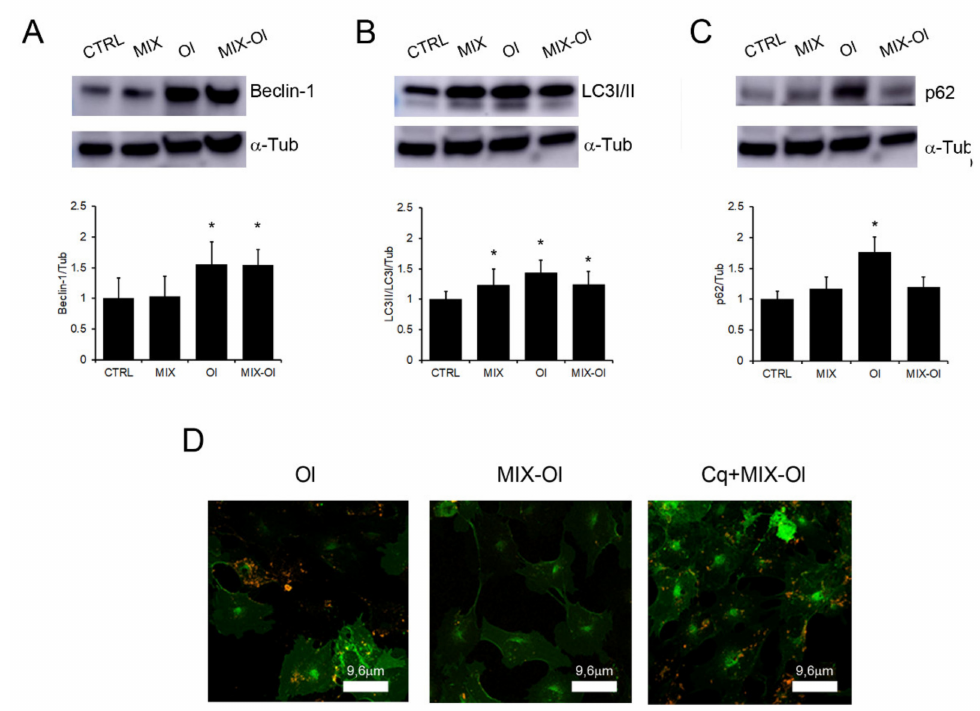
Figure 3. MIX-mediated recovery of redox homeostasis in human neuroblastoma cells depends on autophagosome– lysosome fusion. ( A – C ) The SH-SY5Y cells were treated with (i.) 75 µ M OleA/HT (MIX) for 4 h; (ii.) A β 1–42 oligomers (Ol); (iii.) MIX for 24 h followed by exposure to oligomers for further 24 h (MIX-Ol). Western blots of all the assayed protein markers of autophagy: ( A ) Beclin 1, ( B ) LC3I/LC3II ratio; ( C ) p62. Quantification of signals was determined by densitometric analysis of at least three independent experiments normalized on α − Tubulin ( α − Tub) signals. All the blot signals were normalized with the control untreated SH-SY5Y cells (CTRL). Error bars represent standard errors. *: p -value < 0.05 vs. control untreated cells. ( D ) SH-SY5Y cells were treated with (i.) 2.5 µ M oligomers (Ol) for 24 h; (ii.) MIX (75 µ M) for 24 h and then with oligomers for further 24 h (MIX-Ol); (iii.) CQ (10 µ M) for 16 h followed by different treatments (CQ+MIX-Ol). Immunolocalization of Ol on the plasma membrane by confocal microscopy. The cells were stained with Alexa 488-conjugated CTX-B (green fluorescence); A β 1–42 Ol aggregates were stained with anti- A β 1–42 antibodies and with Alexa 568-conjugated anti-rabbit secondary antibodies (red